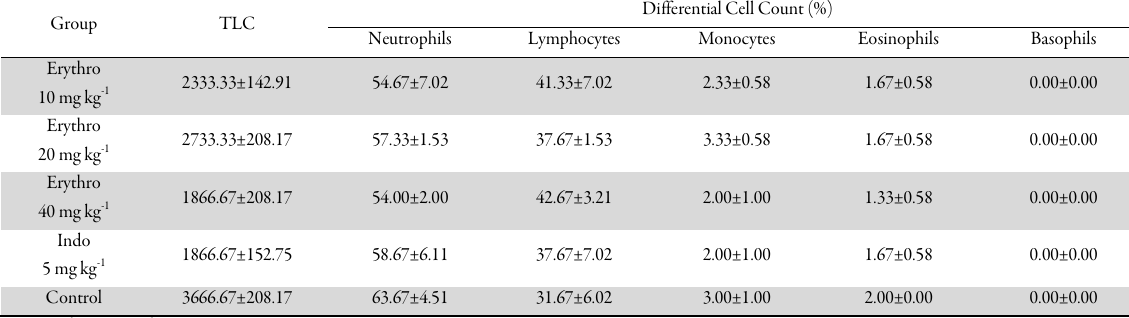
Table 3. Effect of Erythromycin on agar-induced leukocyte